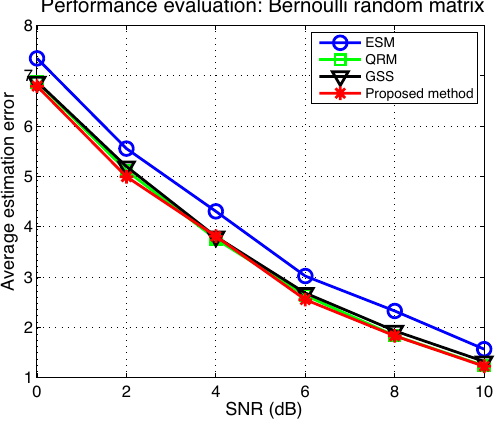
Fig. 5 Performance investigation with respect to SNR for Bernoulli random matrix H : the various sensor selection algorithms with | S | = p = 30 are evaluated by varying the